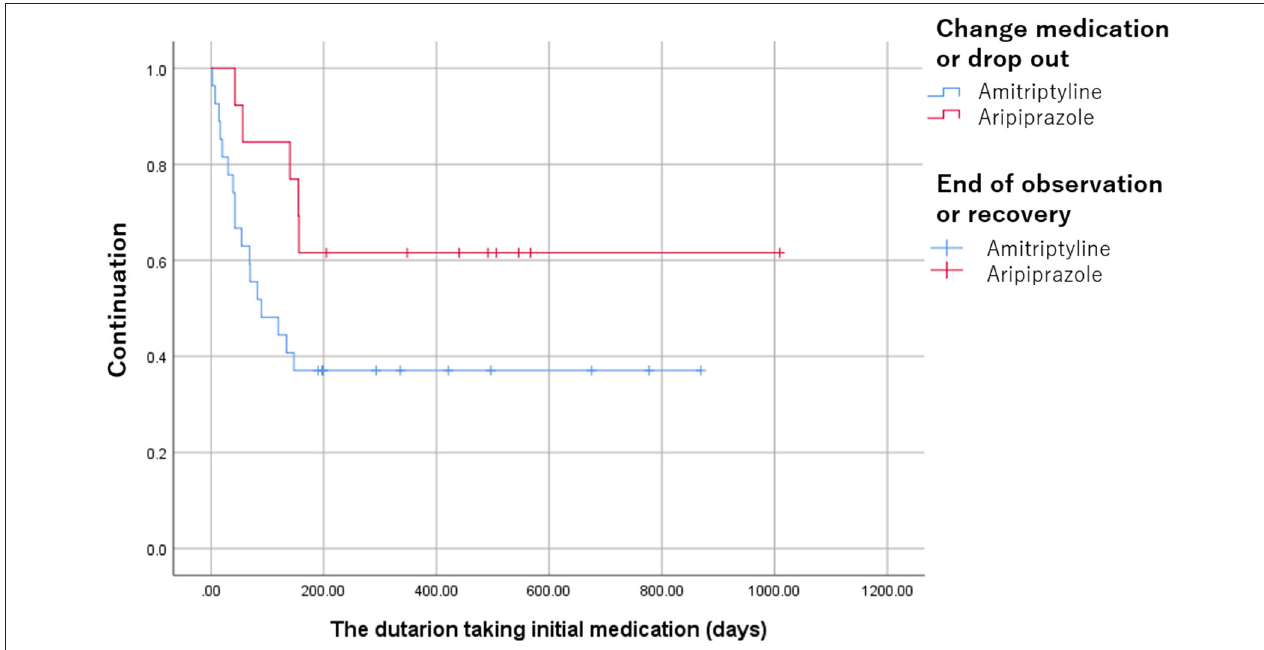
FIGURE 4 | The discontinuation of amitriptyline and aripiprazole. The discontinuation was significantly lower in the patients with amitriptyline compared to the patients with aripiprazole ( p =